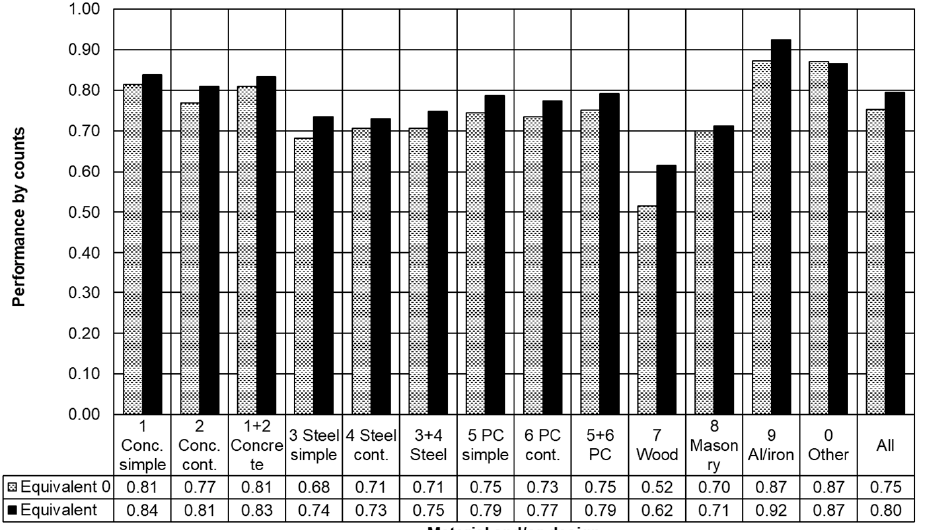
Figure 2. Comparison of structural performances of bridge counts without (Equivalent 0) and with (Equivalent) reconstruction data